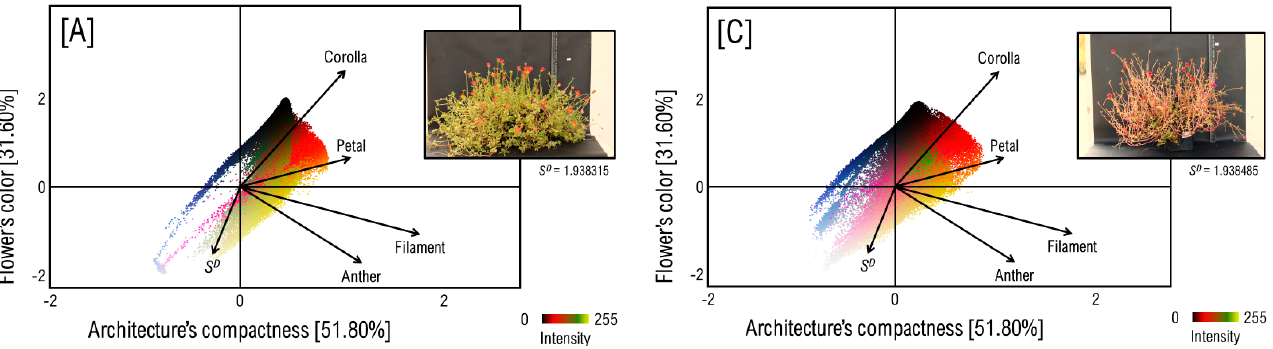
Figure 5. Mapping the botanical and computational features of flower and the architecture of red- flower samples of P. umbraticola . The sequence of alphanumerical symbols, from ( A – D ), relates to the increasing fractality of the pattern in the representation of the digital image. Another significant computational descriptor for the modeling refers to pixel inten- sity. By analyzing the factorial map for white-flower samples (Figure 3), the larger the proportion of high-intensity pixels in the upper right quadrant, the more compact the ar- chitecture and the more intensive the flower’s color. In contrast, low-intensity pixels de- scribe the proportion of either background or vegetative organs in the digital representa- tion of an image. For instance, photogrammetric reconstruction of white-flower samples in the right lower sublevel map of the “eye-catching” panel (Figure 3D) consisted of a larger proportion of low-intensity pixels, because they produced less showy flowers and were structured via the most irregular external shape. In contrast, the photogrammetric reconstruction of white-flower samples in the left upper sublevel map (Figure 3A) con- sisted of a lower proportion of low-intensity pixels, since they produced the largest quan- tity of showy flowers and structured via the most uniform architecture. The PCA allowed for the establishment of functional relationships between features of botany and image for white-flower samples, where the stems visually were not uncom- monly greenish (Figure 2A). However, it did not work properly in discretizing imagery data on yellow-flower (Figure 2B) and red-flower (Figure 2C) samples. The stems of yel- low-flower and red-flower individuals of P. umbraticola were glossy and purplish, making them “confounding” eigenvectors for the biophysical modeling. A graphical characteristic of such confounders in the process of orthogonalization referred to a larger proportion of low-intensity pixels in the right upper quadrant of all sublevel bi-plot diagrams on yellow- flower (Figure 4) and red-flower (Figure 5) samples, even though yellow-flower samples were visually distinctive in the proportion of leaves and stem in the image, and realisti- cally they were graphically similar. Therefore, purplish stems introduced non-random variability into the dataset, “confounding” the algorithm in photogrammetrically recon- structing the spectral signatures of yellow-flower samples. The misinformation-to-infor- mation overlap was clearer in red-flower samples (Figure 5). Other than the purplish stems, the bright yellowish pattern consisting of anthers and filaments in the central